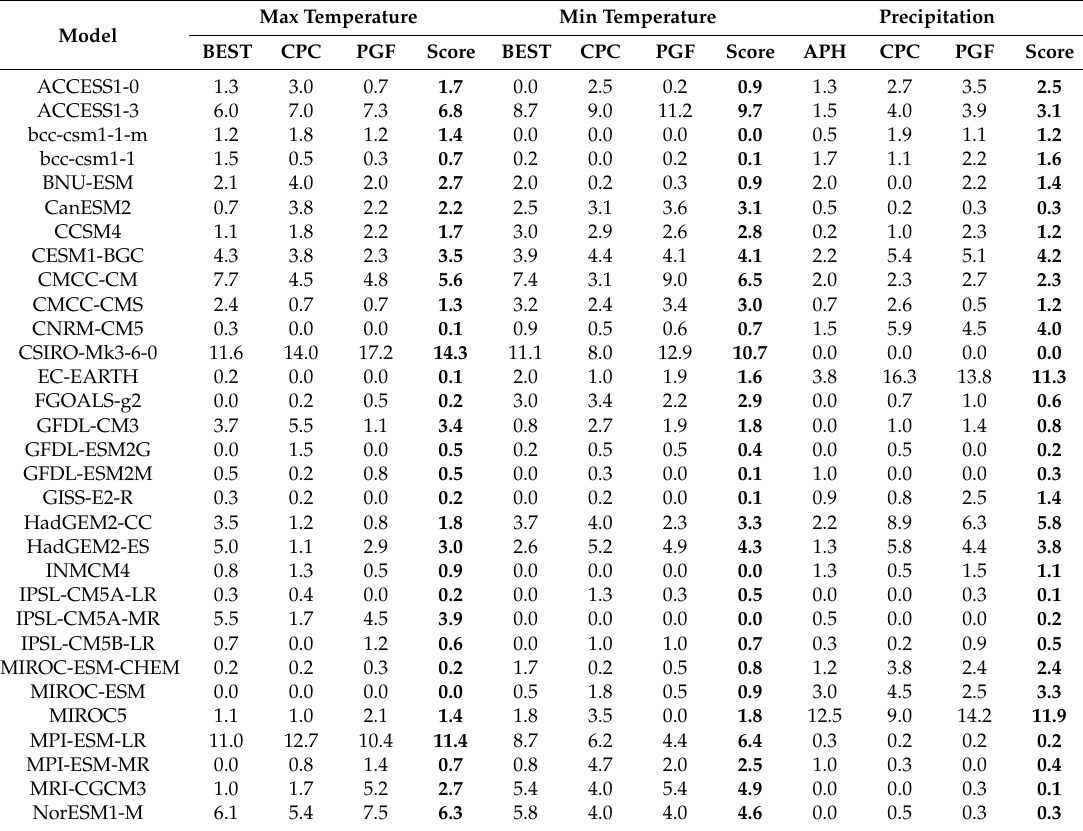
Table 4. The scores obtained by different GCMs according to their performance based on different gridded